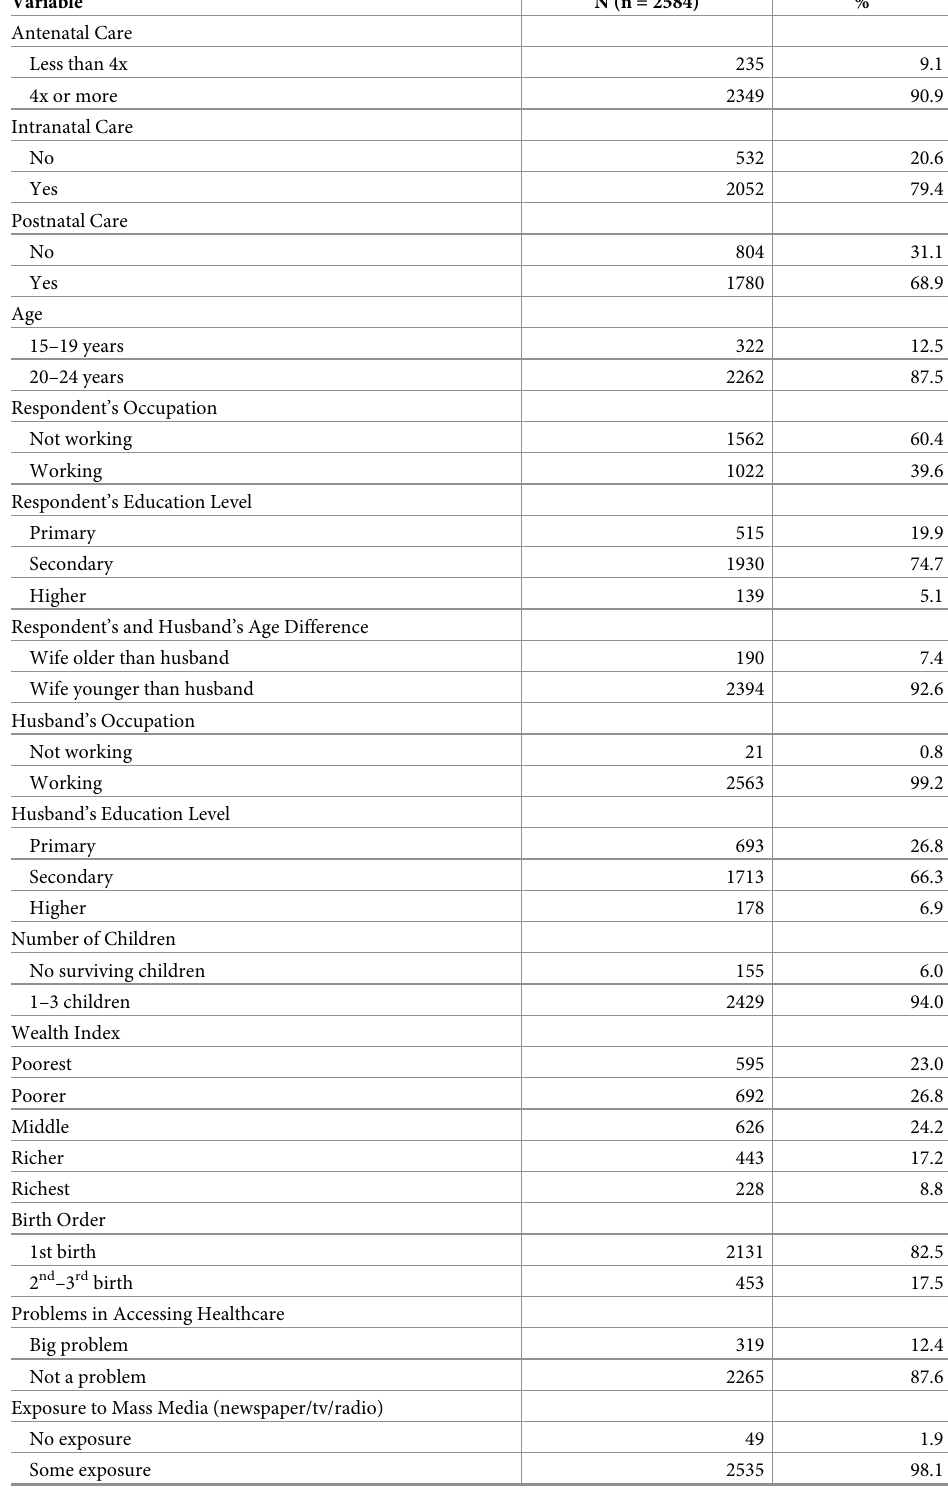
Table 1. Characteristics of mothers aged 15–24 years in